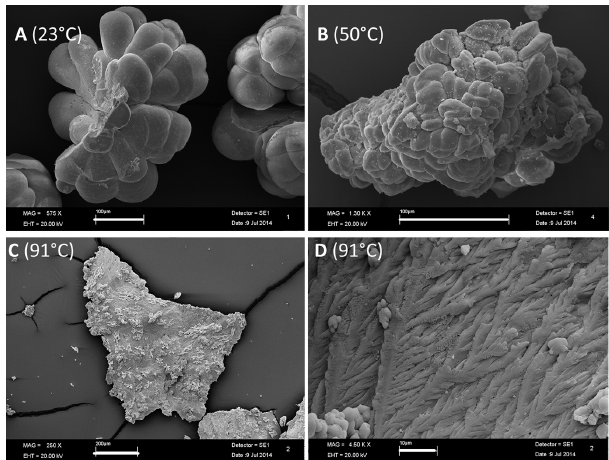
Figure 5. SEM images of vaterite aggregates in the order of increas- ing precipitation temperatures. Scale bars are 100µm in (a) and (b) , 200 µm in (c) and 10µm in (d) . Samples NA-1 (a) , NA-4 (b) , and NA-9 ( c and d ) were used for